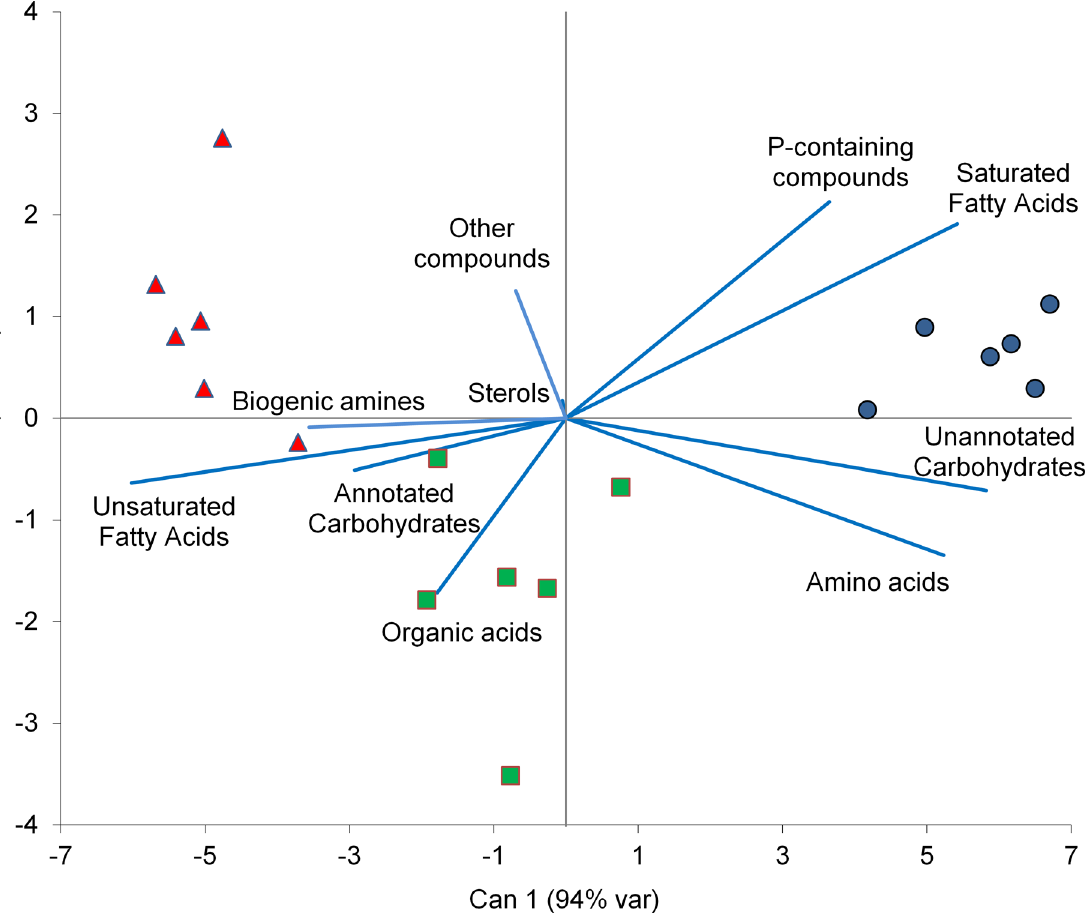
Fig 3. CDA run using biological group means of standardised data from identified GC peaks as vectors. The percentage of the total variance explained by each canonical axis is shown in parentheses. NAT, blue circles; AMF, red triangles; AMF+PGPR, green squares. Please note that CDA vectors do not represent perpendicular directions through the space of the original variables. Fatty acids vectors include both fatty acids and their esters.